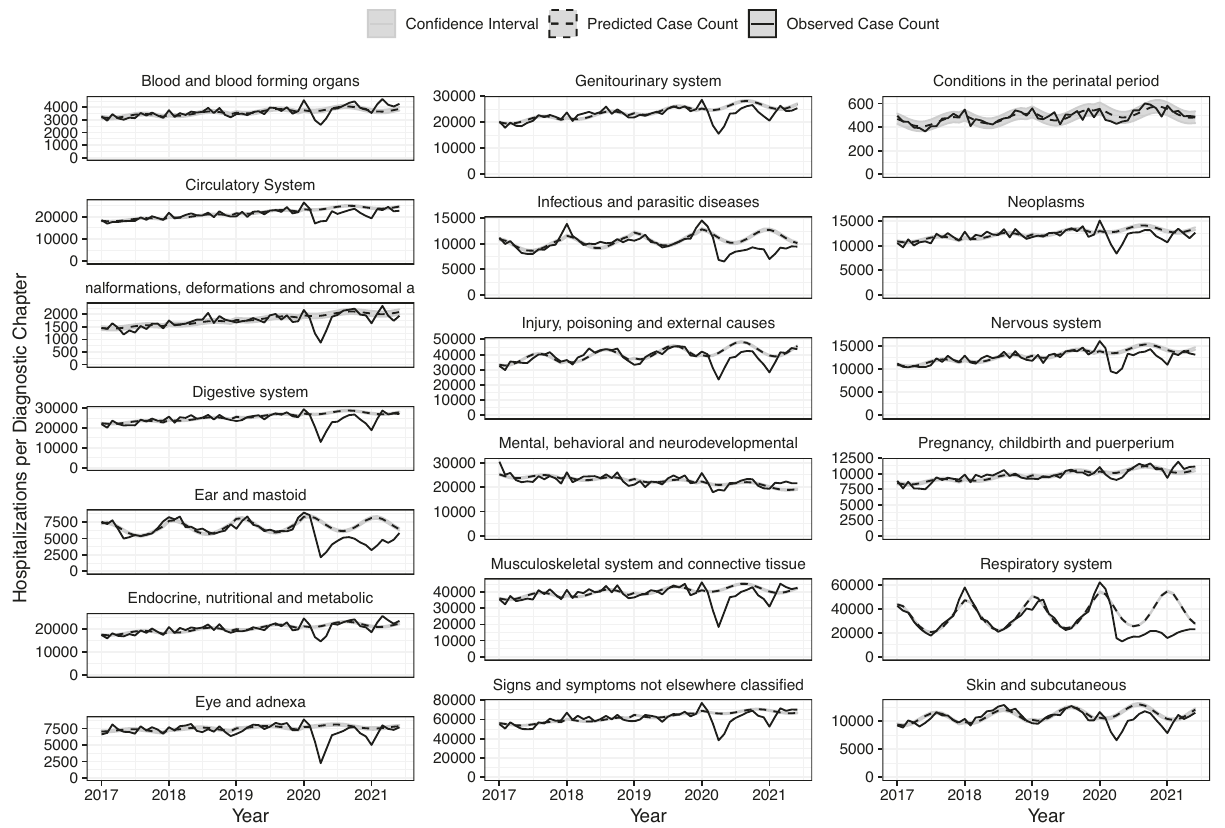
Fig. 1 | Time series of observed hospitalizations per diagnostic chapter by monthandyear(solidline)withmodelpredictedcasecounts(dashedline)and prediction intervals (grey). Note: Data are presented as the observed case count per month (black), with regression model predicted case counts (dashed black)